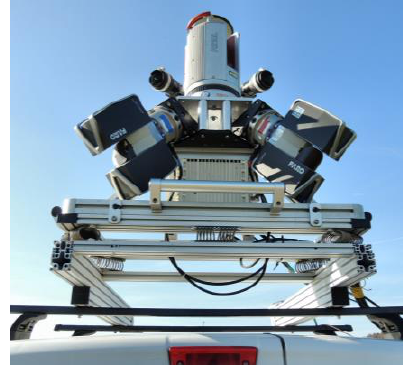
Figure 1: Mobile mapping system IGI-SAM used for the test